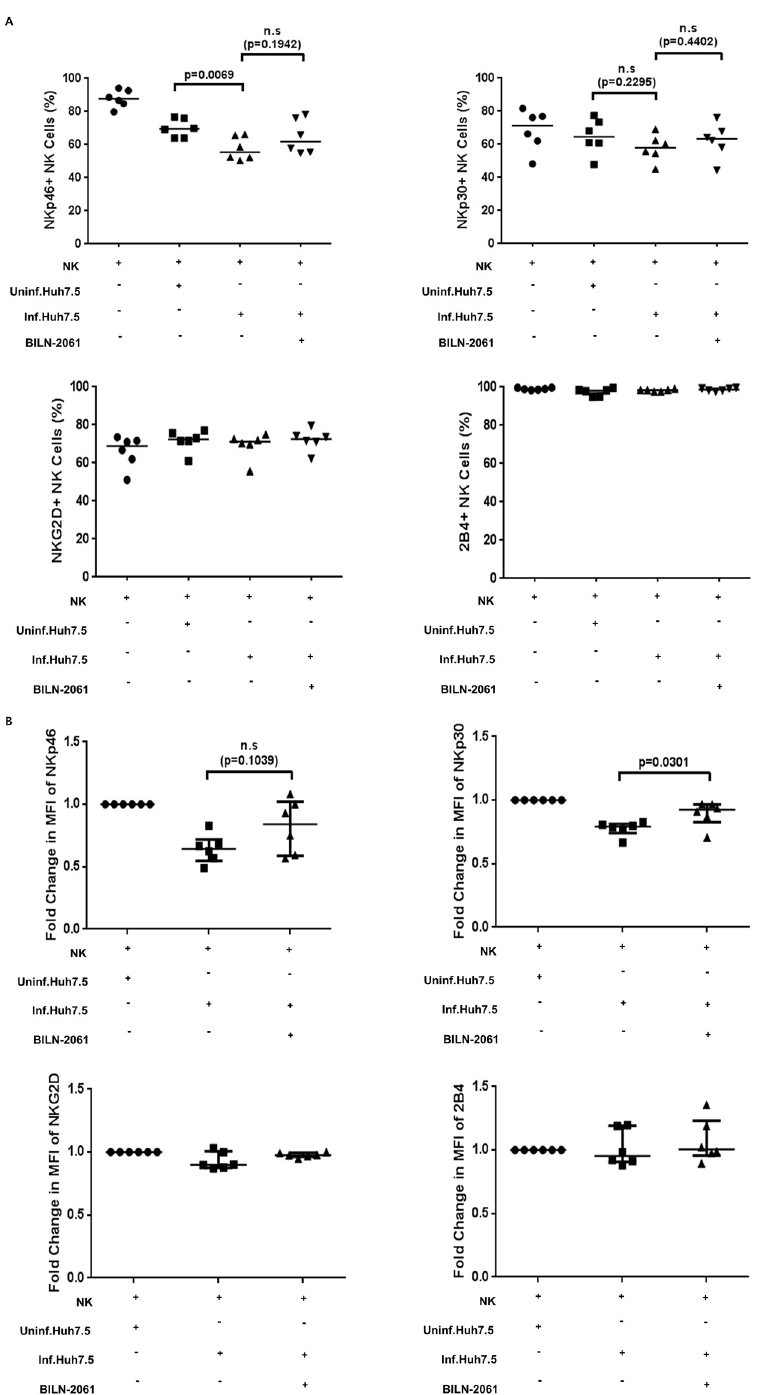
Fig 4. Activating NK cell receptors expression after interaction with BILN-2061-treatedHCV-infected Huh-7.5 cells. (A) NK cells were co-cultured with uninfected, HCV-infected, or BILN-2061-treated HCV- infected Huh-7.5cells for 18 h, and the frequencyof expressingactivatingNK cell receptors was measuredby flow cytometry. Frequenciesof NKp46 + , NKp30 + , NKG2D + and 2B4 + NK cells are shown. (B) Effect of BILN- 2061-treated HCV-infected Huh-7.5cells on the expressionlevels of activatingreceptors on NK cells. NK cells were co-culturedwith uninfected, HCV-infected, or BILN-2061-treated HCV-infected Huh-7.5cells for 18 h. Fold changein the mean fluorescence intensity (MFI) of NKp46, NKp30, NKG2D, and 2B4 on NK cells is shown as relative values to uninfectedHuh-7.5 cells. Error bars indicate the medianwith interquartile range.